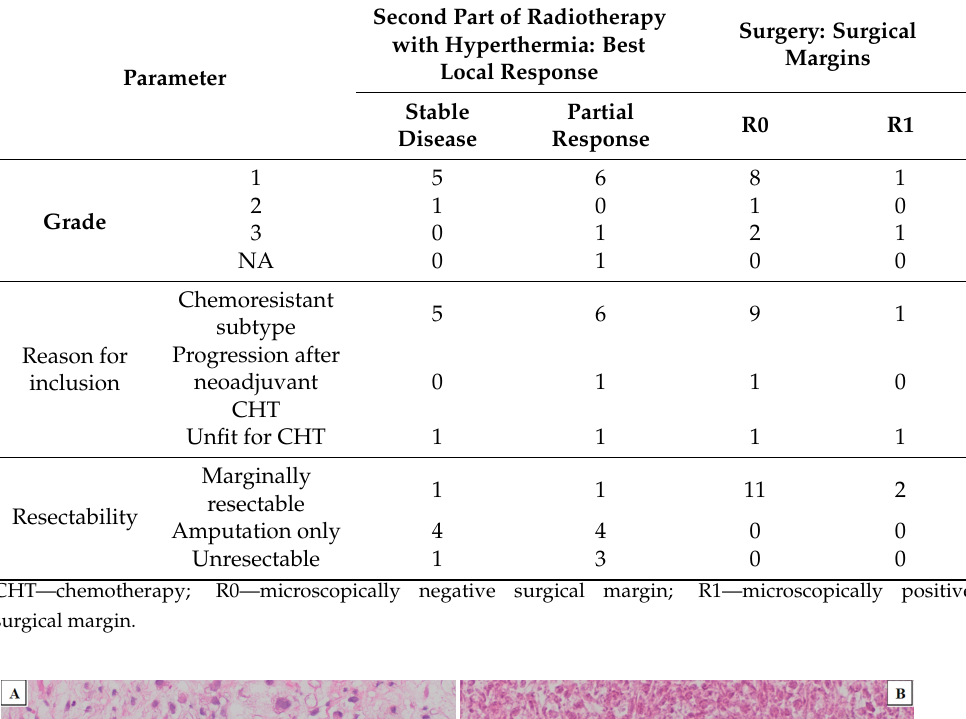
Table 2. Outcomes of treatment among patients who completed the protocol.